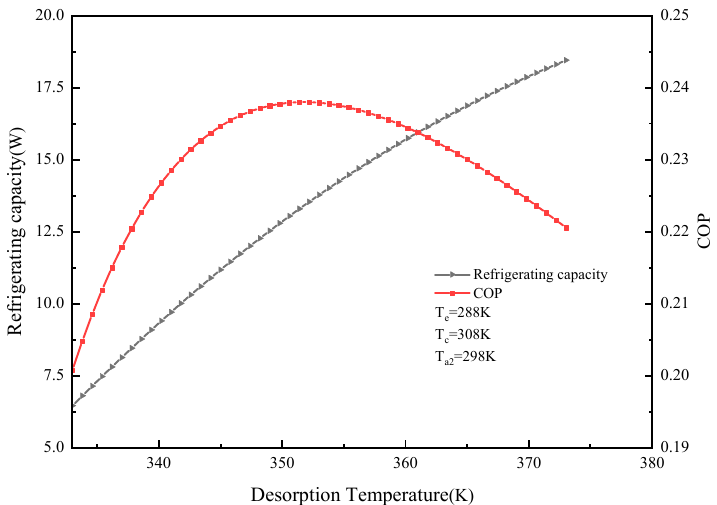
Figure 6. Effect of desorption temperature on refrigeration capacity and coefficient of performance (COP).